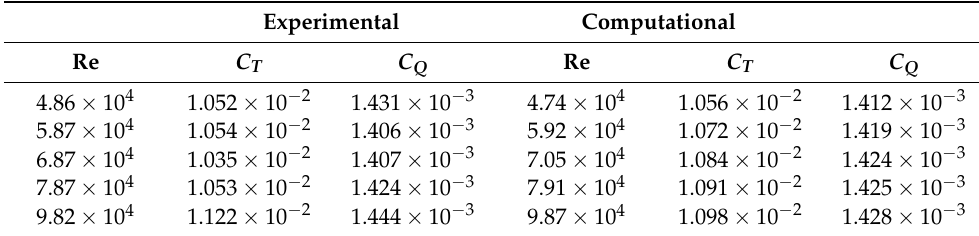
Table 2. Experimental and computational thrust and torque coefficients.